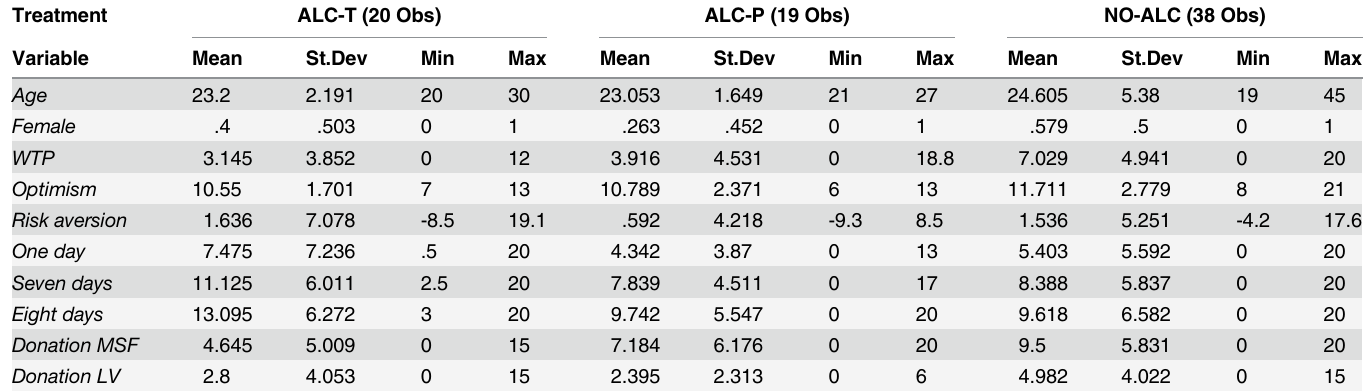
Table 1. Summary